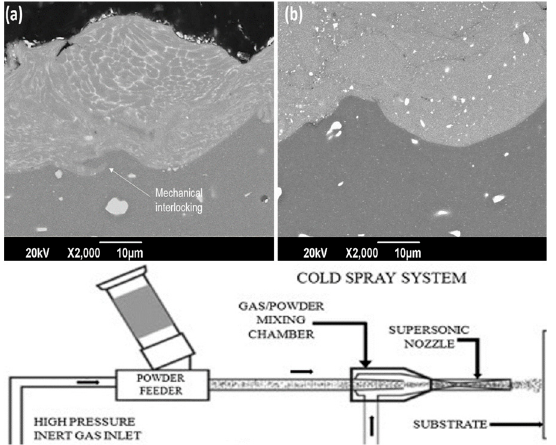
Figure 11. Top: SEM micrographs of cold spray-coated AA6061 substrate by ( a ) as-received and ( b ) heat-treated AA7075 particles with a mechanical interlocking between the coating and the substrate [105]. Bottom figure: a schematic view of cold spray coating process [106] .